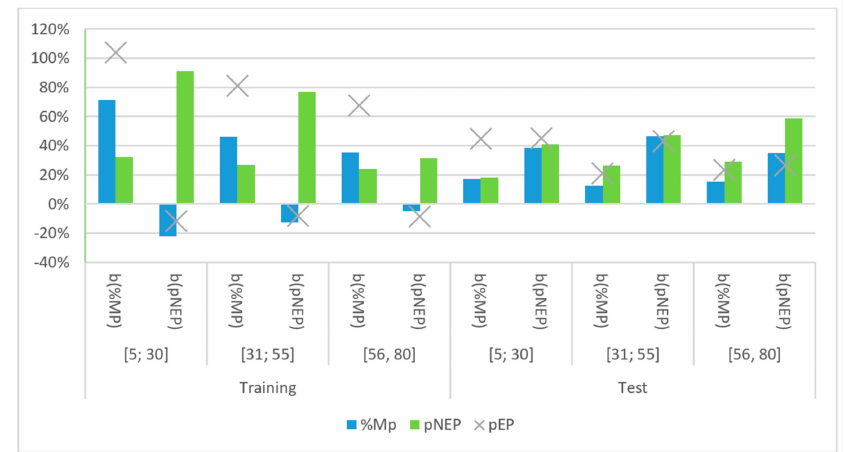
Figure 6. The highest values of %MP, pNEP and pEP indicators, considering the number of neurons in the hidden